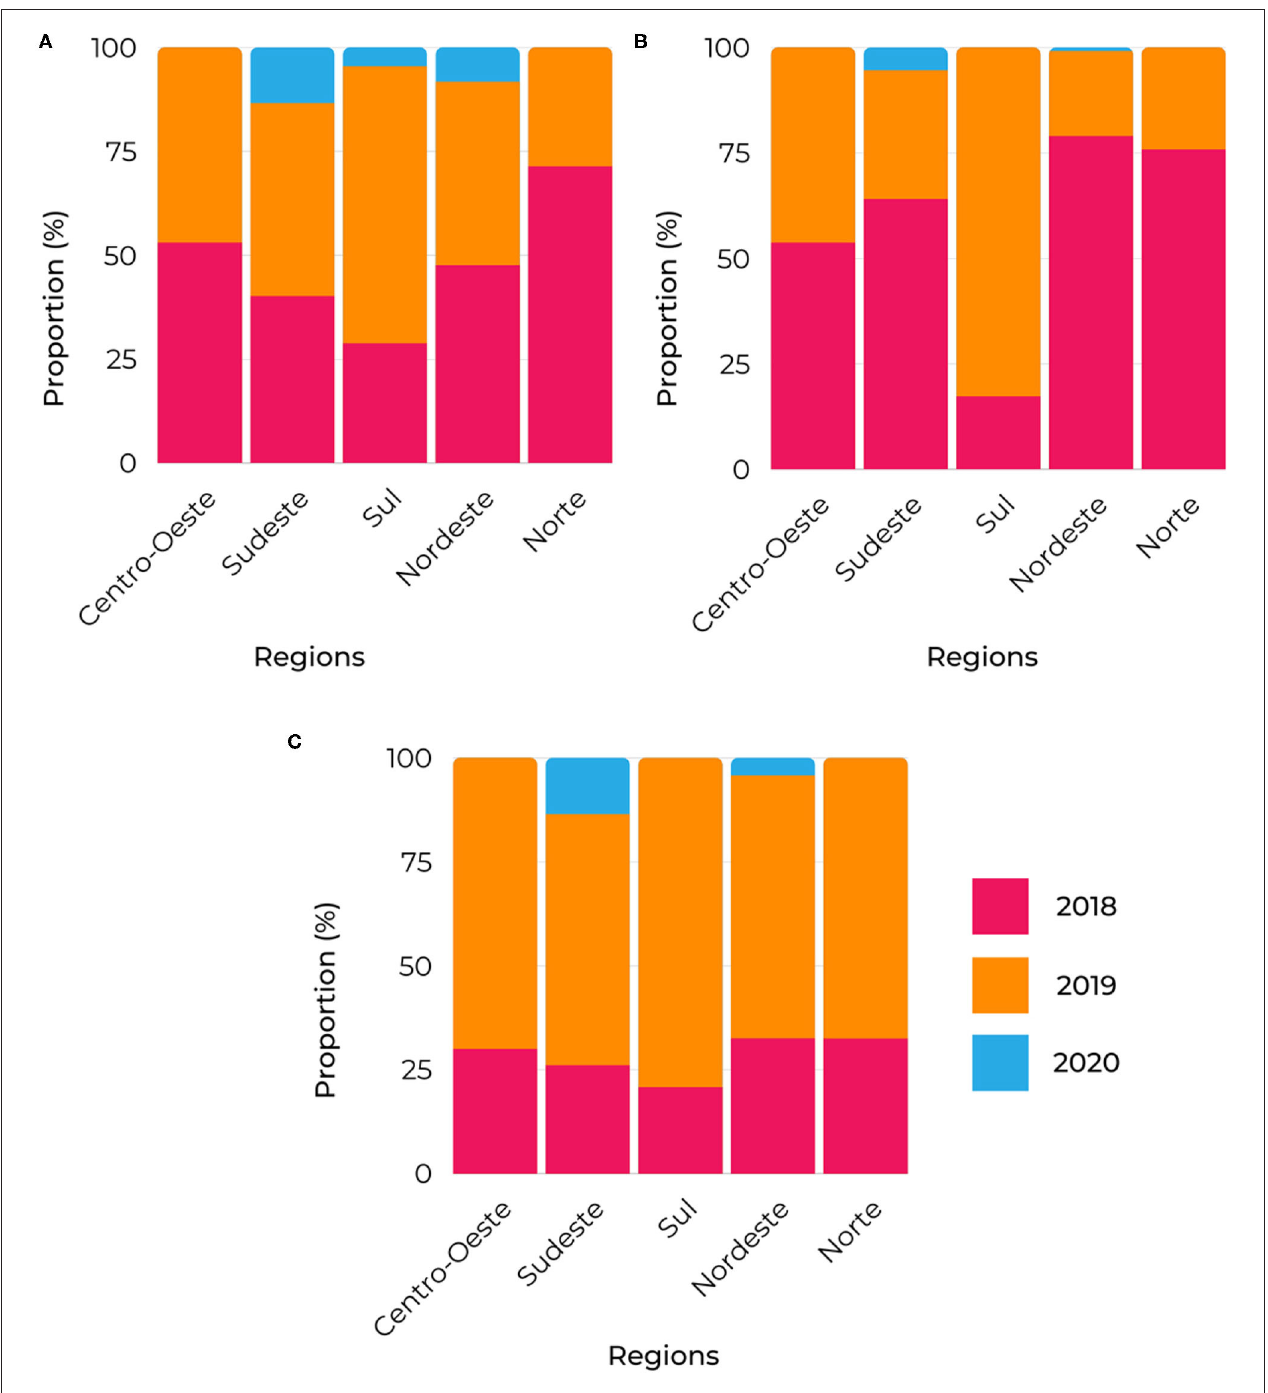
FIGURE 8 | Trigrams proportion of relevant terms segmented by region. (A) investigation vertical transmission, congenital syphilis cases, vertical transmission syphilis and investigation committee transmission; (B) municipal health plan, municipal health secretariat, municipal health council, annual health program and confrontation congenital syphilis; (C) primary health center, rapid syphilis network, rapid syphilis territory, congenital syphilis pregnant, health care network, primary care surveillance and line care